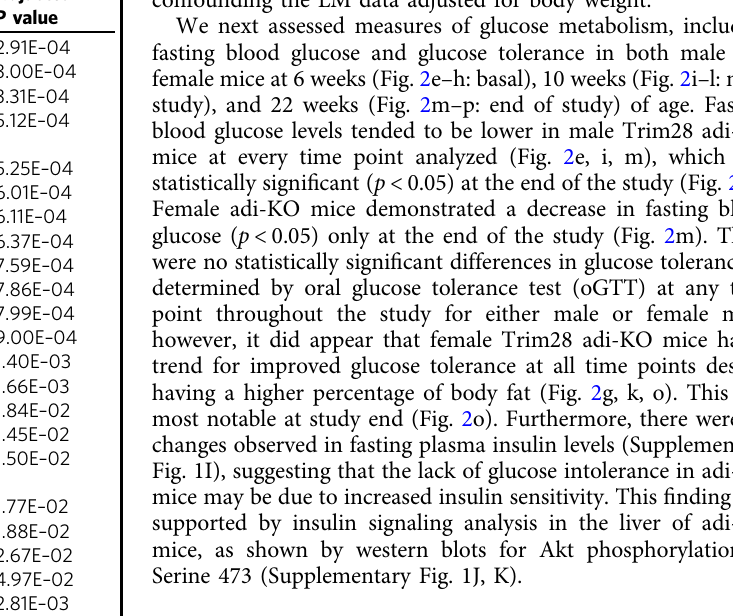
Fig. 1 Trim28 expression is reduced in differentiated adipocytes and in WAT from mice deleted for Trim28. Protein and gene analyses were performed in 3T3-L1 adipocytes at different time points pre and post differentiation. a Representative immunoblot for Trim28, PPAR γ , and 14-3-3 over a differentiation time course in 3T3-L1 cells, and ( b ) densitometry analysis of the Trim28 blots normalized to 14-3-3 and presented as relative to pre-differentiated 3T3-L1 Trim28 expression, n = 2. c Trim28 mRNA expression in non-differentiated (non-diff) and day 6 differentiated (diff day 6) 3T3-L1 cells, * p < 0.05 versus non-diff as analyzed by ANOVA with Fisher ’ s LSD post hoc testing, n = 13 non-diff, n = 12 diff. Cell culture experiments were repeated at least three times each. Protein and gene expression analyses performed in gonadal fat pads from Trim28 wild type (WT) and adipose-speci fi c Trim28 KO (KO) mice. d Immunoblot of Trim28 and 14-3-3 in WT and adi-KO male and female fat pads. e Trim28 densitometry normalized to 14-3-3 relative to WT ( n = 7 WT and adi-KO male mice, n = 7 WT and n = 5 adi-KO female mice), * p < 0.05 versus WT mice as analyzed by ANOVA with Fisher ’ s LSD post hoc testing. f Trim28 mRNA expression in WAT, BAT, quad, and liver of WT and adi-KO mice ( n = 10 per group), * p < 0.05 versus WT mice as analyzed by ANOVA with Fisher ’ s LSD post hoc testing, n = 12 WT and n = 12 KO. All data are presented as mean ± SEM. WAT white adipose tissue, BAT brown adipose tissue, Quad quadriceps muscle. marked differences in LM observed between WT and adi-KO Table 1 Phenotypic traits correlated with Trim28 expression mice (Supplementary Fig. 1A to Supplementary Fig. 1B and in mouse adipose tissue from >100 strains of mice from the Supplementary Fig. 1E to Supplementary Fig. 1F, respectively), hybrid mouse diversity panel (HMDP). NMR = nuclear although there was a small but signi fi cant change in LM as a magnetic resonance. Data statistically analyzed using percentage of body weight in female mice (Supplementary Biweight midcorrelation Fig. 1F). However, no changes were observed in absolute LM (Supplementary Fig. 1E), suggesting that the increased FM was confounding the LM data adjusted for body weight.